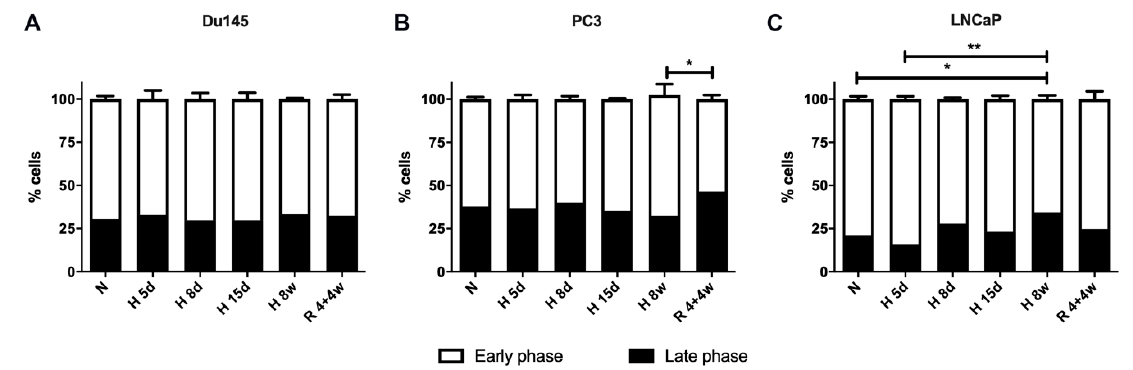
Figure 3. Cell cycle distribution in early or late phase for ( A ) Du145, ( B ) PC3 and ( C ) LNCaP cells, analyzed using flow cytometry. Data from cells under normoxia (N), acute hypoxia (5 d, 8 d, 15 d—days 5, 8 and 15), chronic hypoxia (8 w—8 weeks) and recovery (4 + 4 w—4 weeks hypoxia + 4 weeks normoxia). Data from ( A – C ) represent mean ± SEM of a minimum of three independent experiments. ** p < 0.01, * p < 0.05.